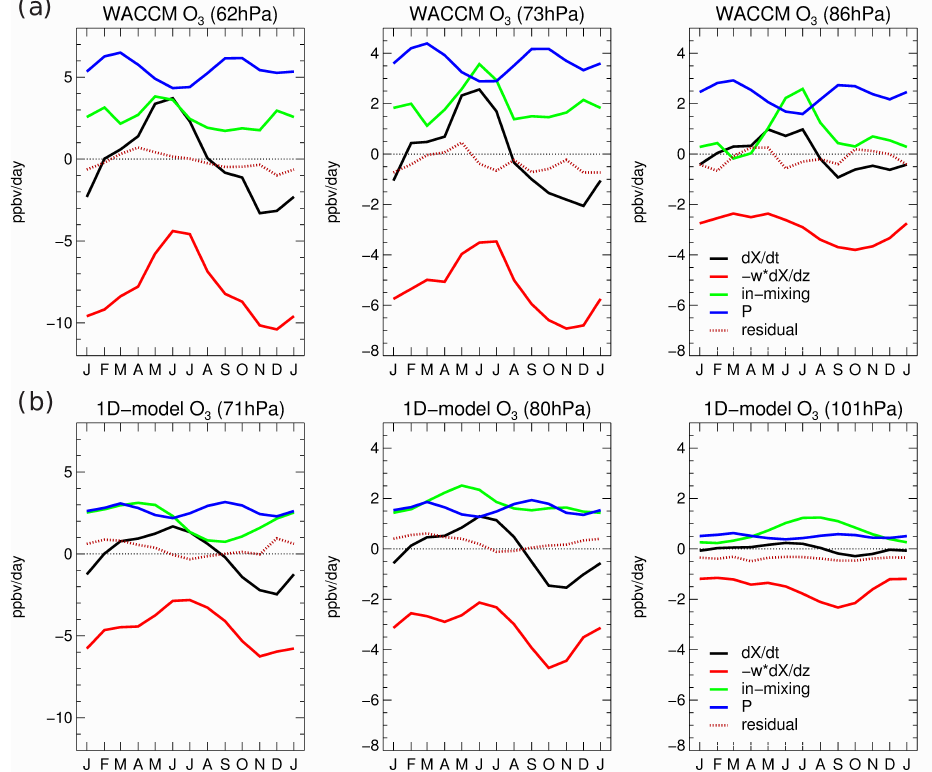
Fig. 2. Seasonal cycle of the various tendency terms in the TEM equation for mean tropical ozone concentration (20 ◦ S–20 ◦ N) computed from WACCM (a) , after Abalos et al. (2013), and from the 1-D Lagrangian model results (b) at different pressure levels (see text for details). Shown are the net tendency (black), the contributions due to vertical advection (red), horizontal transport (green), photochemical production (blue), and a residual term (red dashed). In order to account for the vertical shift of the tropopause altitude in WACCM, the balances are shown at slightly higher log-pressure altitudes than in the 1-D model (see text for details). Units: [ppbvday − 1